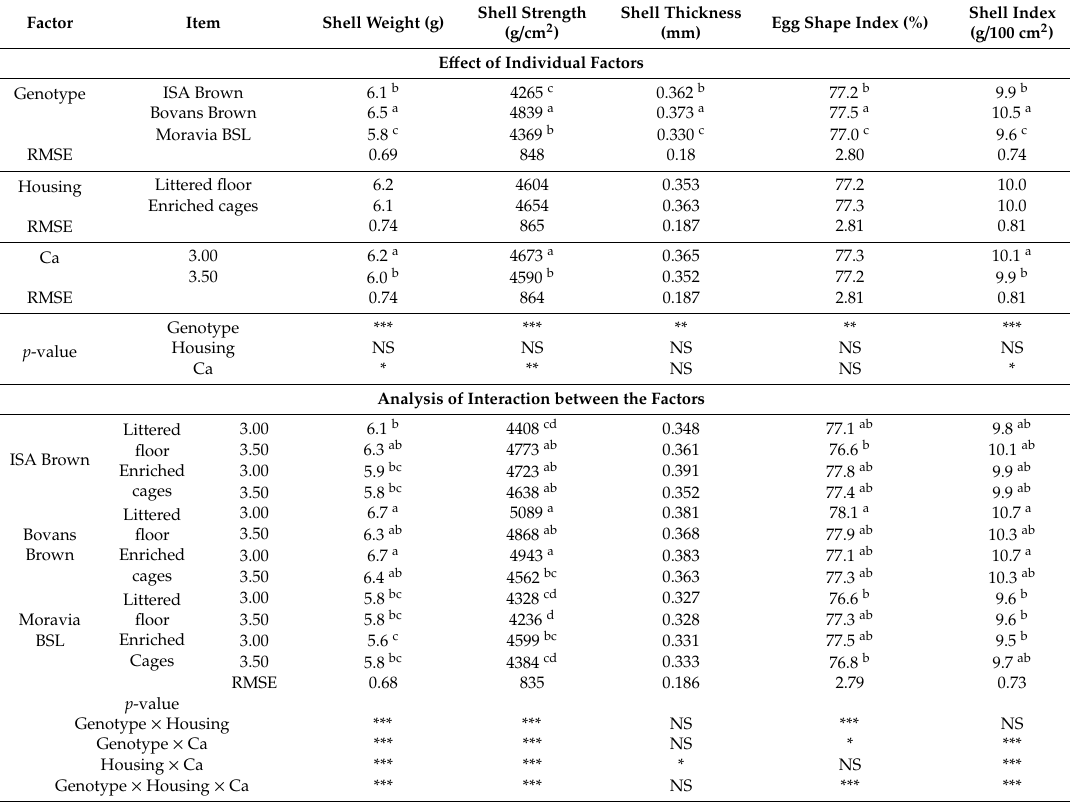
Table 3. The e ff ects of genotype, housing system, and feed Ca level and their interactions on eggshell quality